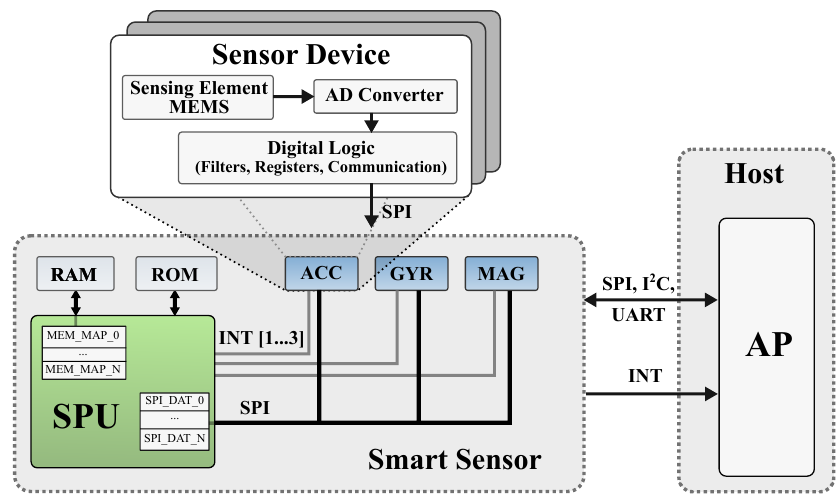
Figure 1. Typical structure of a smart